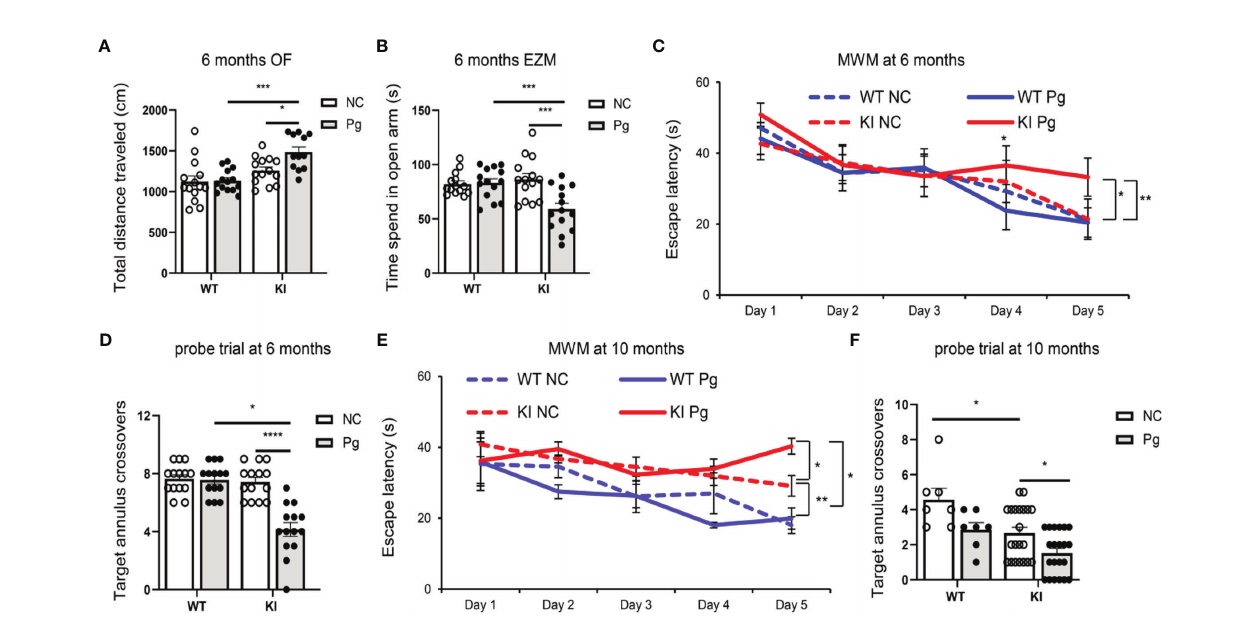
FIGURE 2 | Pg infection worsens cognitive and behavior impairment in App KI mice. (A) Total distance traveled in open fi eld (OF) tests at 6 months of age. cm, centimeter. (B) Time spent in open arm in elevated zero maze (EZM) tests at 6 months of age. s, second. (C, E) Escape latency in Morris water maze (MWM) tests at 6 (C) and 10 (E) months of age. (D, F) Target annulus crossovers in probe trial tests at 6 (D) and 10 (F) months of age. A-D, n=14/group; E-F, n=21/ group ( App KI mice), n=7/group (WT mice). Data are expressed as mean ± SEM. * P < 0.05, ** P < 0.01, *** P < 0.001, **** P < 0.0001 by two-way ANOVA followed with Tukey